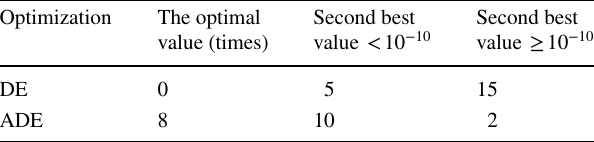
Table 1 Comparison of test results between ADE and DE Optimization